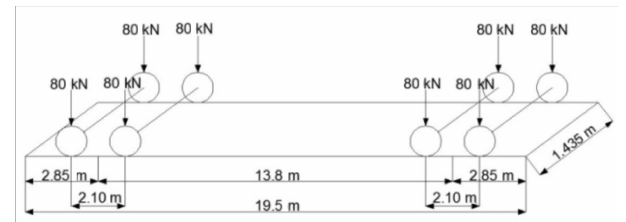
Figure 3. Configuration of the train